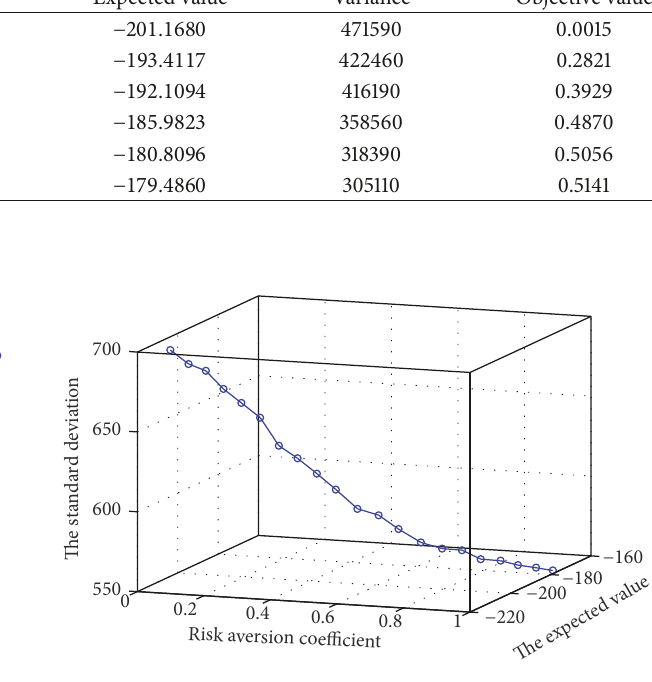
Figure 8: The three-dimensional demonstration of relationships among 𝜇 , 𝜎 , and 𝜆